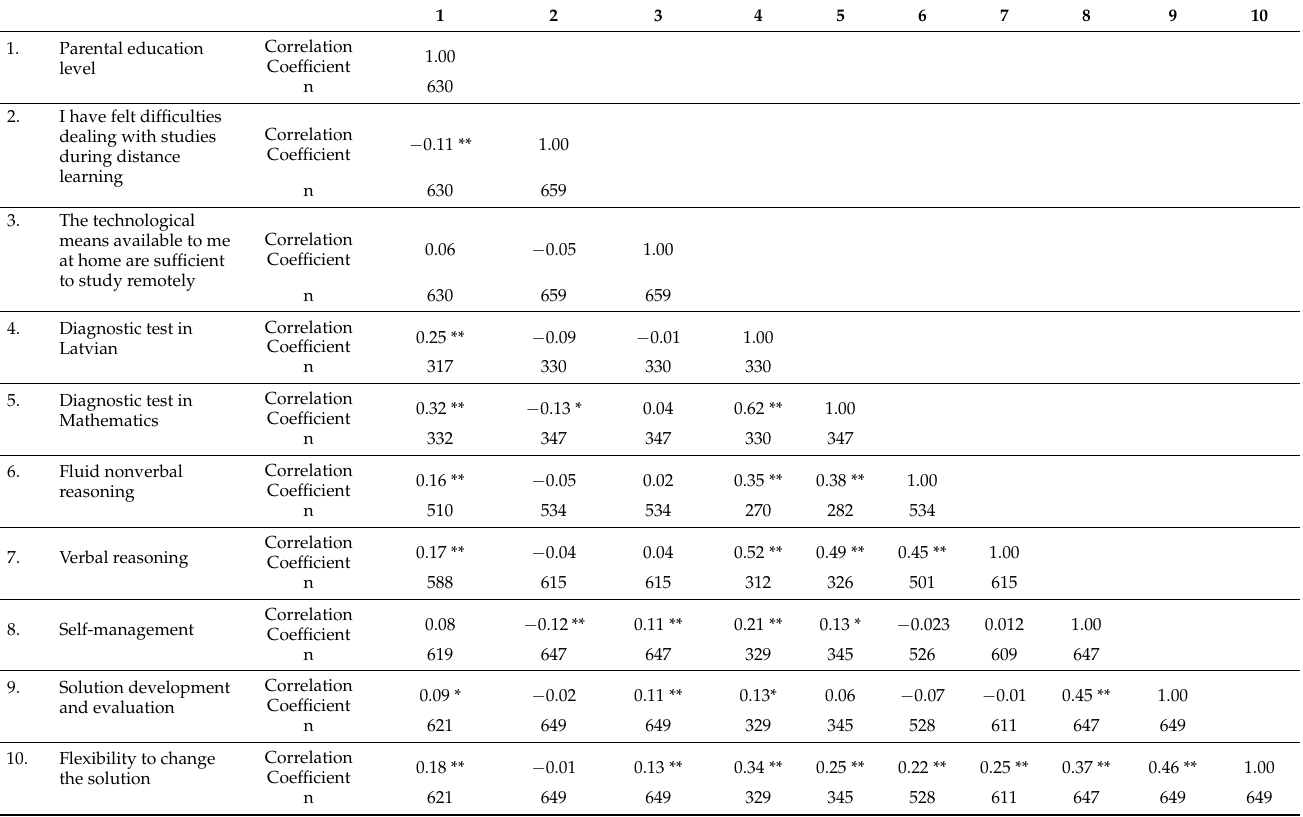
Table 2. Correlations between the measured indicators for the students in the 9th